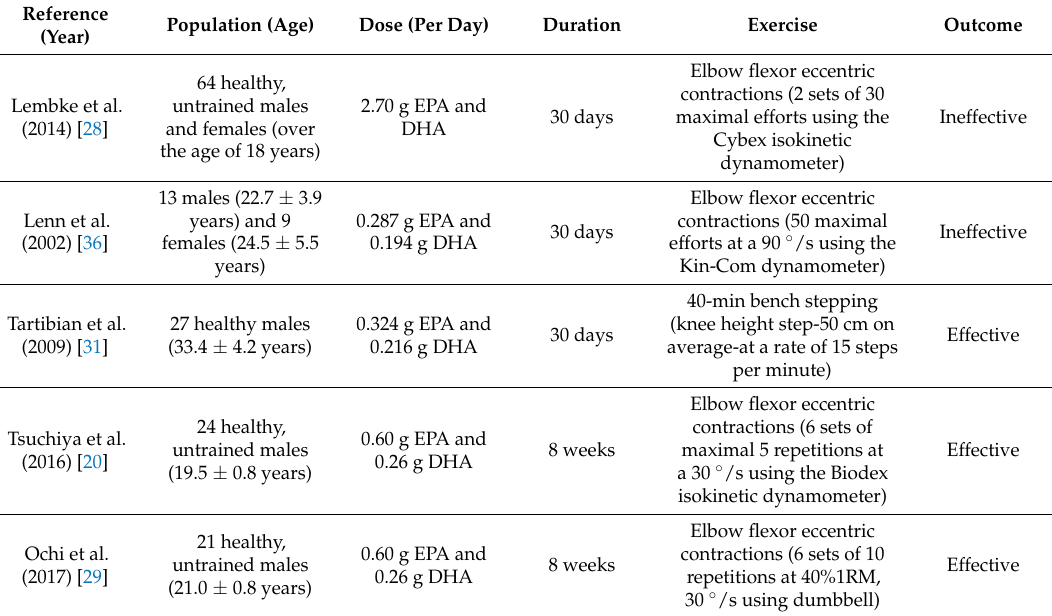
Table 3. Summary of the effects of EPA/DHA supplementation on range of motion.